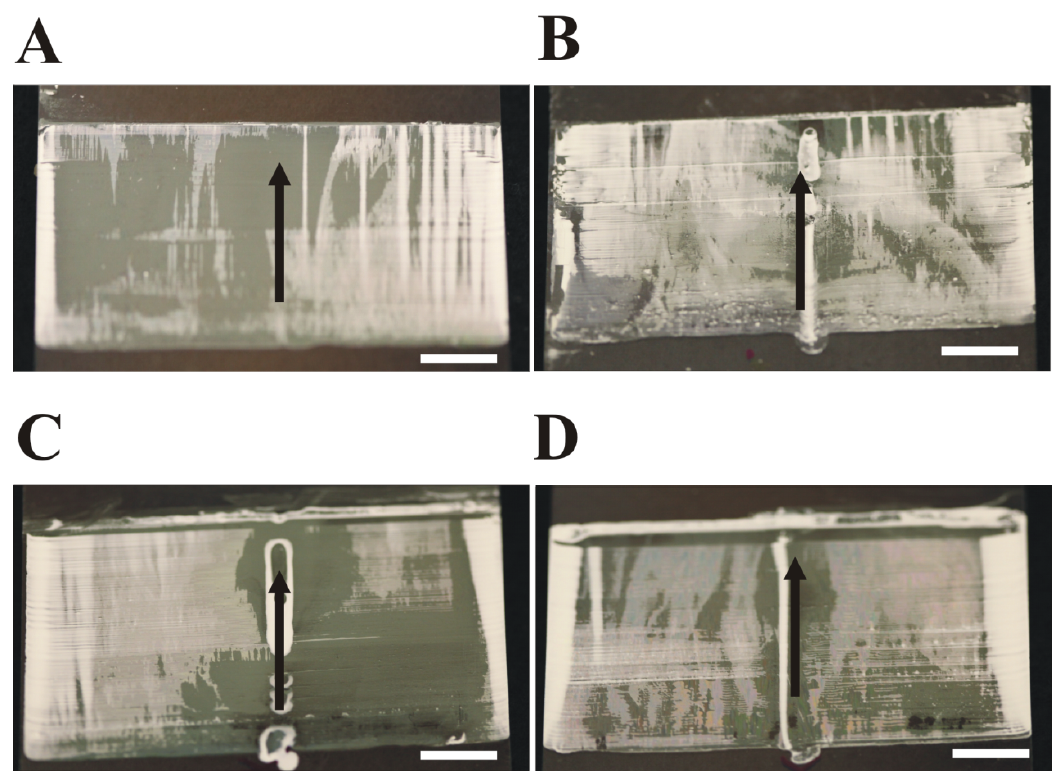
Figure 8. Structure of coatings deposited from a 1.0 µm microsphere suspension at a volumetric delivery rate of ( A ) 0.0 (batch), ( B ) 1.0, ( C ) 2.0, ( D ) 4.0, and ( E ) 6.0